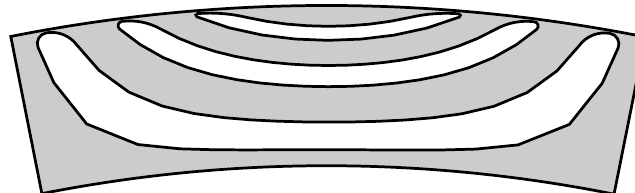
Figure 4. SynREL motor without PM (SynREL).